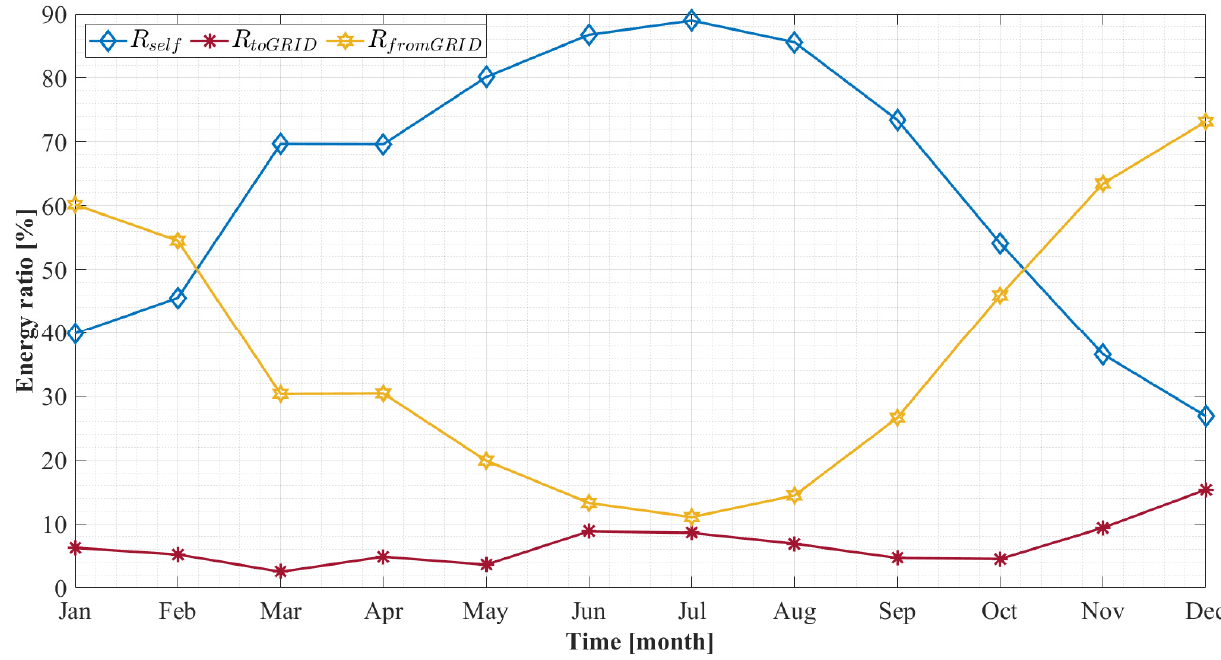
Figure 9. Energy ratios.